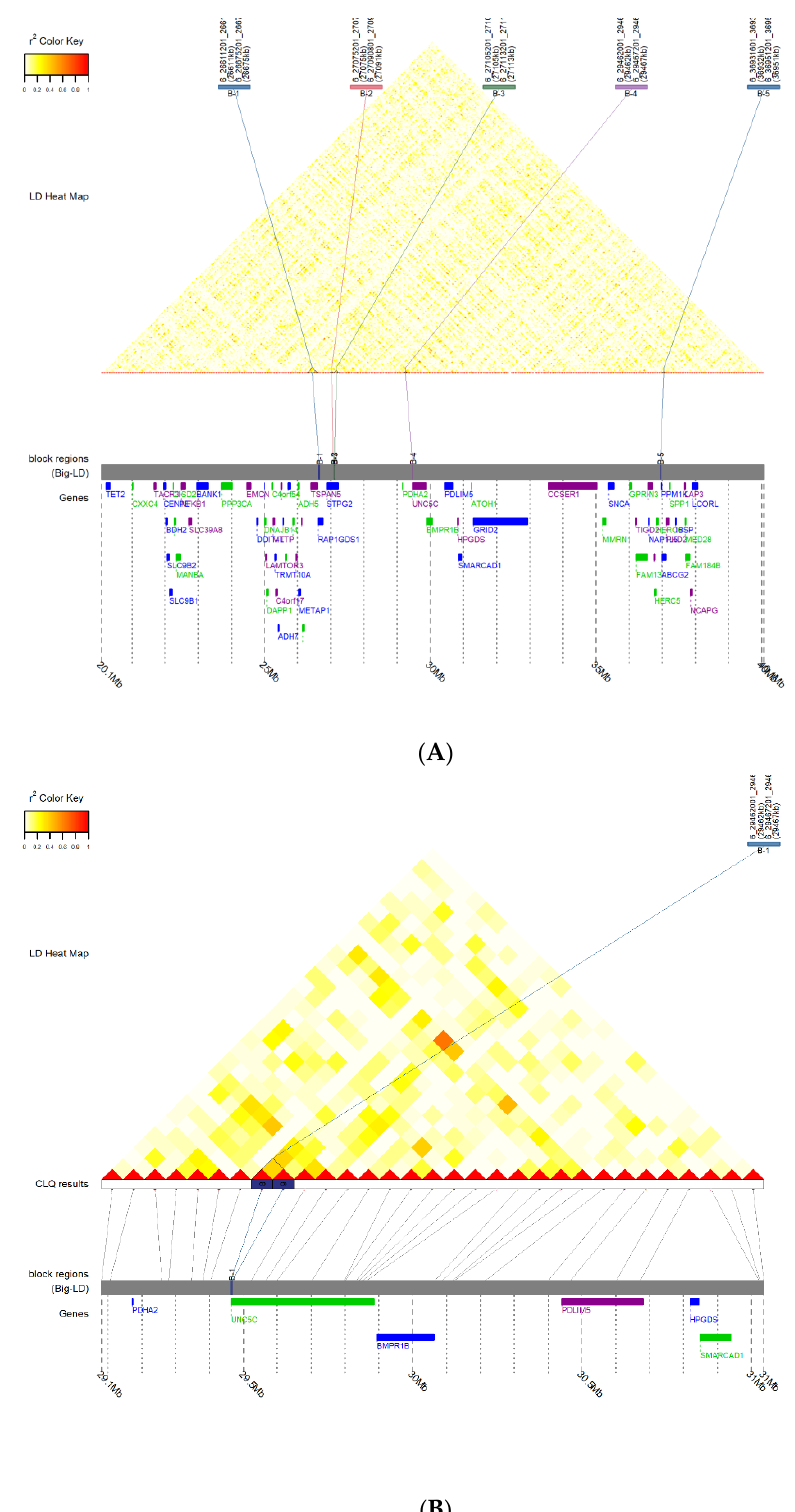
Figure 7. LD block between CNVs at 10 Mb ( A ) or 1 Mb ( B ) distances upstream and downstream of the Fec B gene.